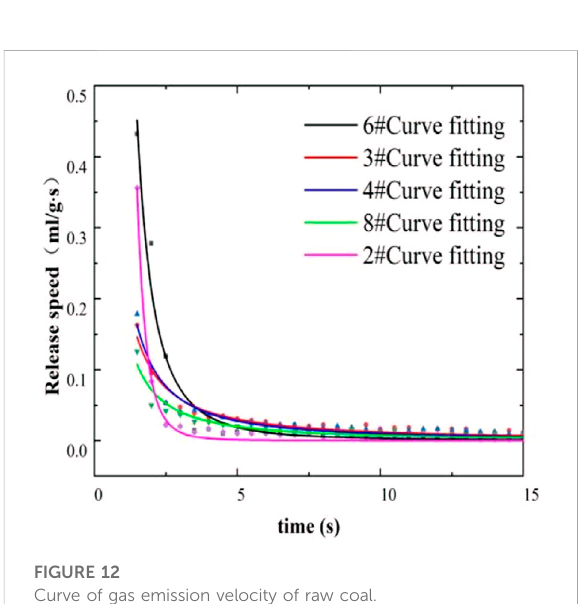
FIGURE 11 Variation of Δ p value and total gas emission in 0 – 60s of coal in igneous rock intrusive zone.